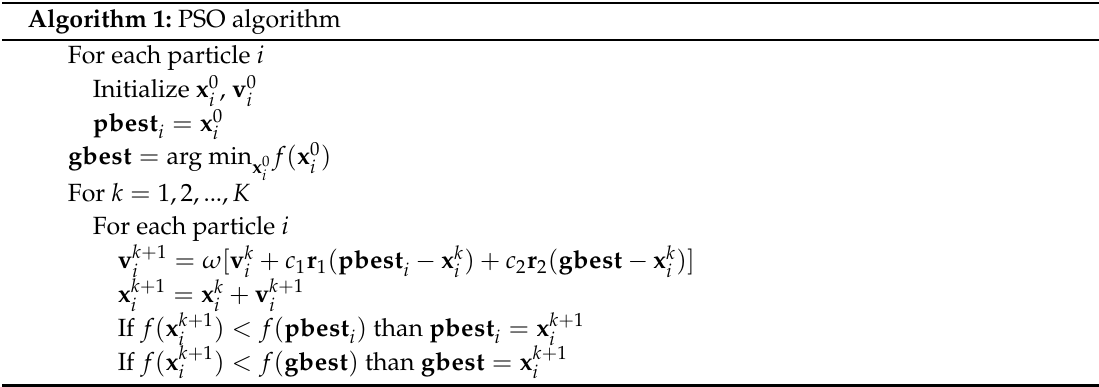
Algorithm 1: PSO